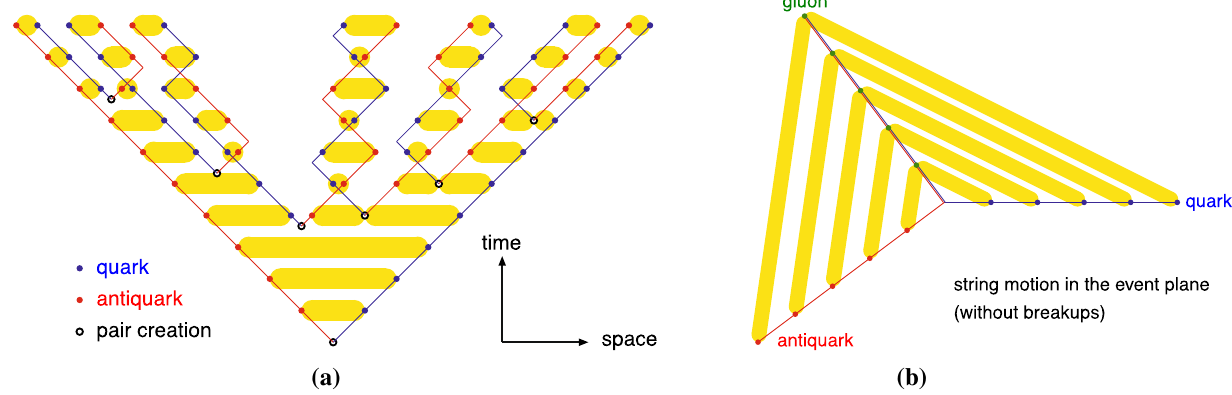
Fig. 1 a String breakup in a qq event. The points denote the location of quarks and antiquarks at snapshots in time, and the yellow regions the string pieces then stretched out between them. b String drawing in the plane of a qqg